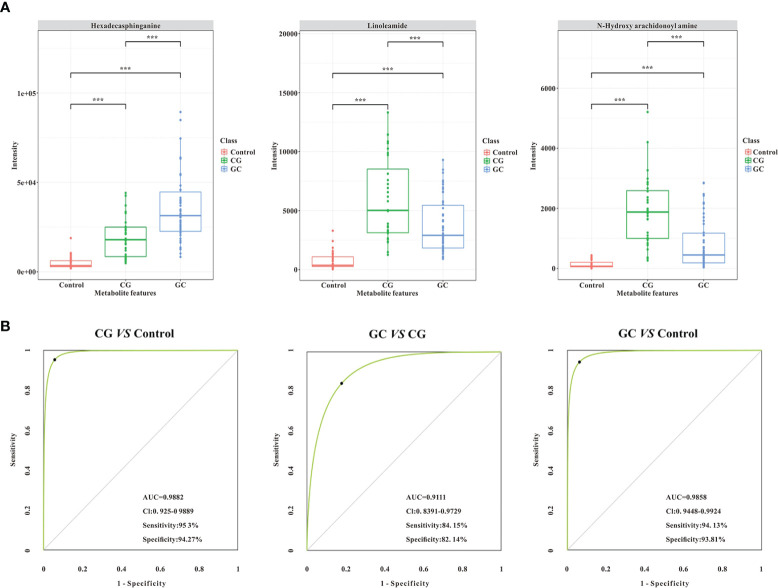
Validation of the combination of the three lipid metabolites (AUC > 0.90, ***p < 0.005) as potential biomarkers by ROC curve analysis. (A) The comparison of normalized intensity peak areas of three candidate biomarkers (hexadecasphinganine, linoleamide, and N-Hydroxy arachidonoyl amine) in the control (orange), CG (green), and GC (blue) groups. (B) Potential diagnostic performance of the three identified metabolites (AUC > 0.90, ***p < 0.005). The sensitivity and specificity values were optimized by PLS-DA. As shown in the panels, the area under the ROC curve of the combination of the three candidate biomarkers is significantly increased, suggesting that the combination of the three parameters has the highest diagnostic accuracy, especially for distinguishing GC patients from CG patients.